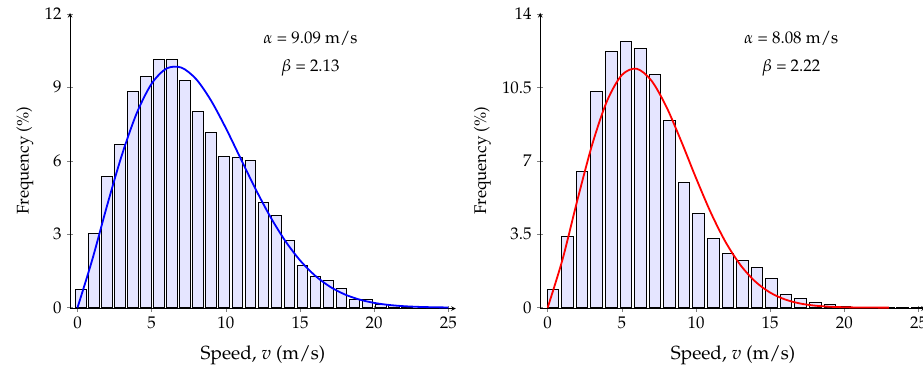
Figure 8. Frequency distribution for Overberg (left) and Komsberg (right).